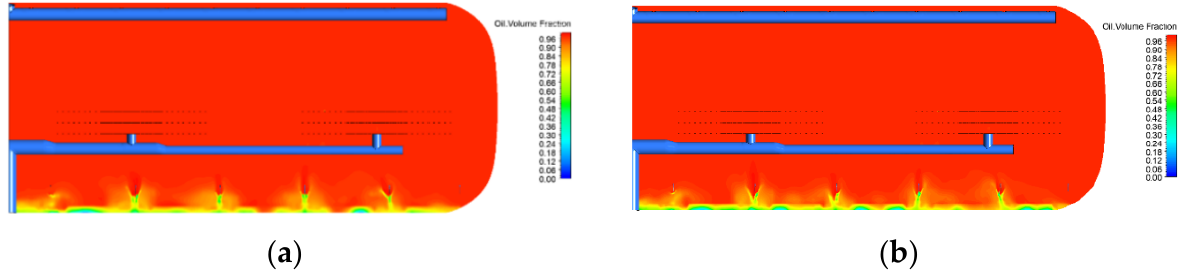
Figure 6. Effect of the droplet size on the oil volume fraction in a longitudinal plane for ( a ) high droplet size, experiment 6 (D = 20 µm, µ = 0.017 kg/ms, x = 0.03, and E = 3 kV/cm); ( b ) low droplet size, experiment 5 (D = 1 µm, µ = 0.017 kg/ms, x = 0.03, and E = 3 kV/cm).